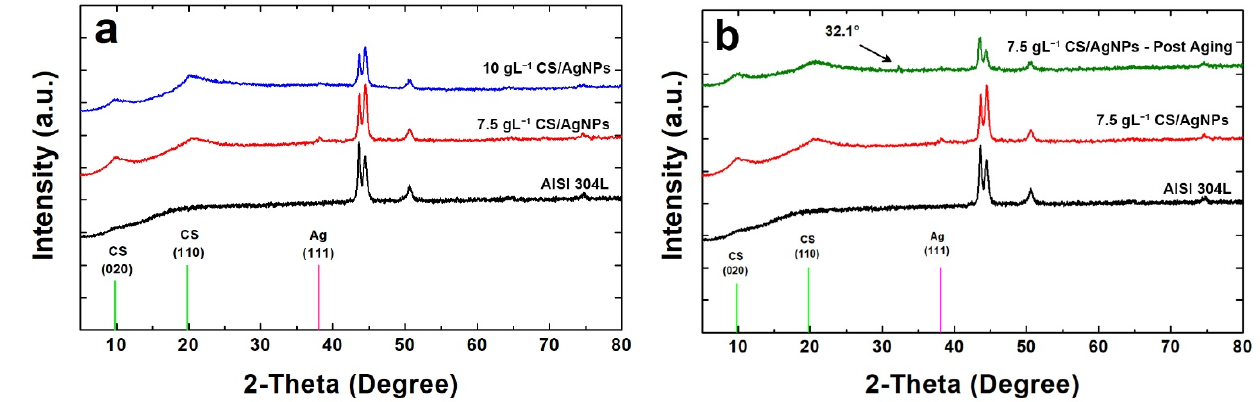
Figure 4. XRD patterns of the samples: ( a ) before and ( b ) after aging in